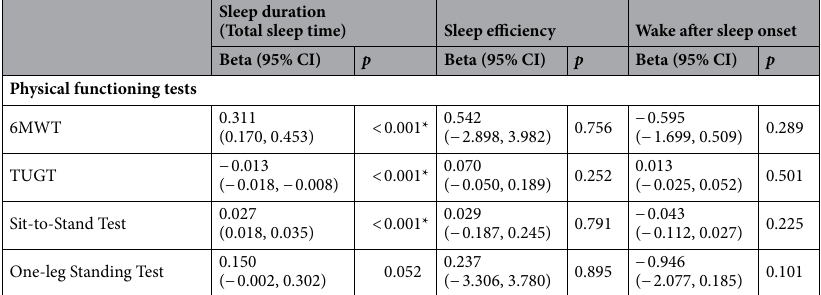
Table 4. Univariable regression model for objective sleep measures with physical performance. * p < 0.05.